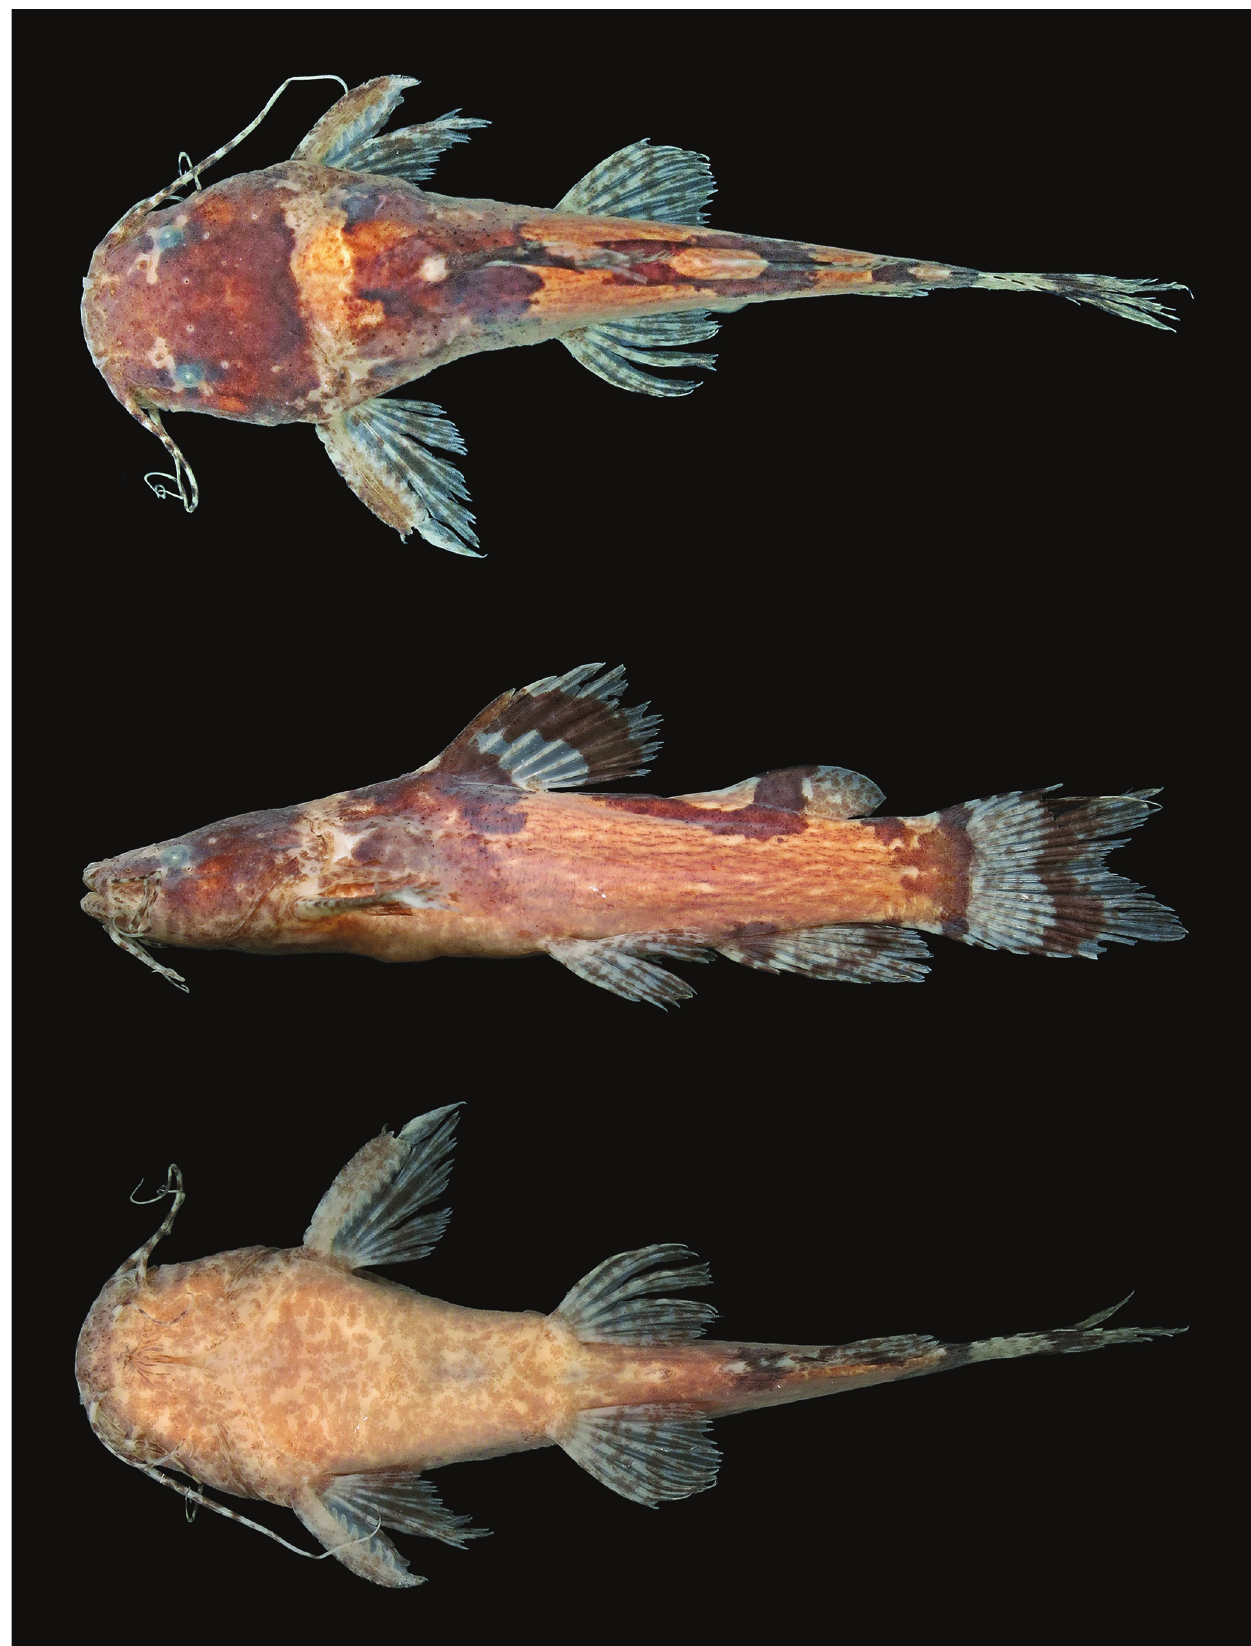
Fig. 1. Microglanis leniceae , holotype, ZUFMS 4148, 33.0 mm SL, rio Betione, Miranda, Mato Grosso do Sul State,